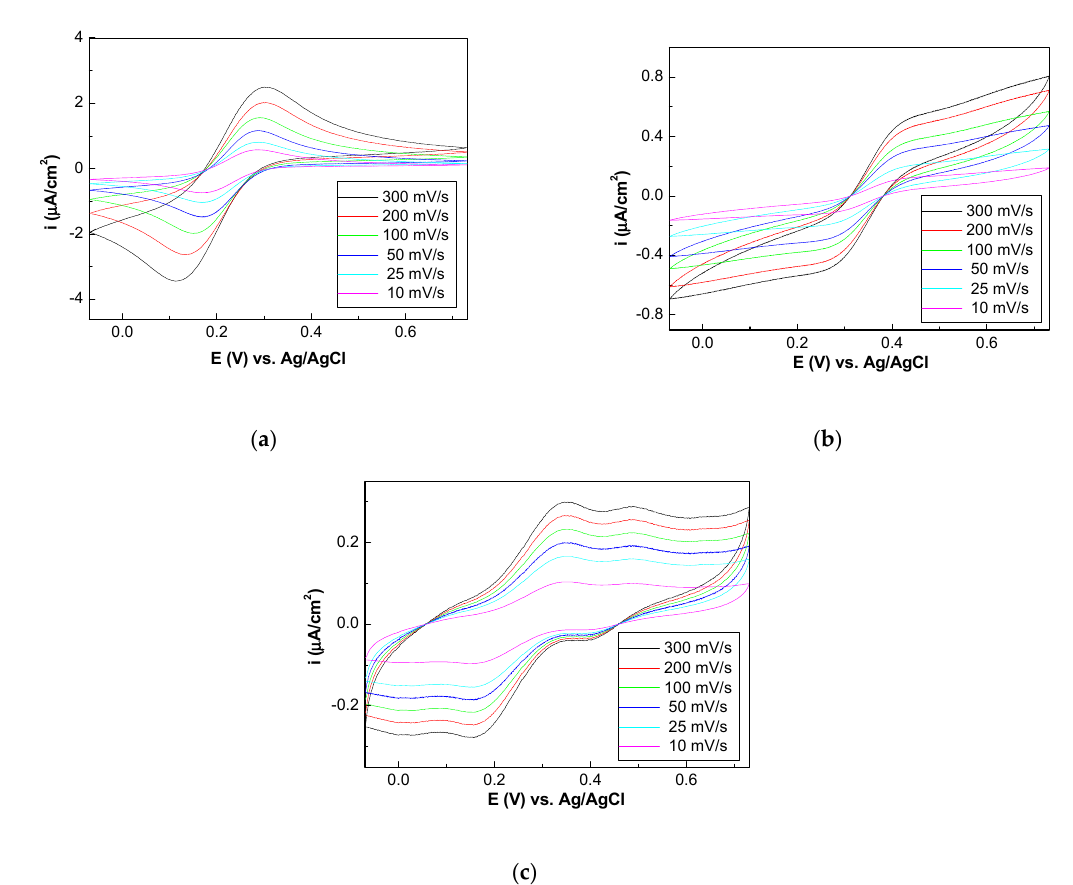
Figure 6. Cyclic voltammograms of the electrodes of Au ( a ), SPCE-RGO ( b ), SPCE-RGO/PDPA-PDITC-G-anti-EGFR/EGFR ( c ), with 5 mM K 3 [Fe(CN) 6 ]/K 4 [Fe(CN) 6 ] solution in 0.1 M PB with pH = 7.4. Cyclic voltammograms were recorded with scan rates equal to 300 (black curve), 200 (red curve), 100 (green curve), 50 (blue curve), 25 (cyan curve) and 10 mV s − 1 (magenta curve). Table 1. The potential of the anodic and cathodic peaks ( E pa , E pc ) as well as current densities ( i pa , i pc ) of the cyclic voltammograms as depending on the scan rate ( v ) of the following electrodes: Au, SPCE-RGO, SPCE-RGO/PDPA-PDITC-G-anti-EGFR/EGFR. Δ E = E pa − E pc corresponds to the potential of separation of the anodic and cathodic peaks.